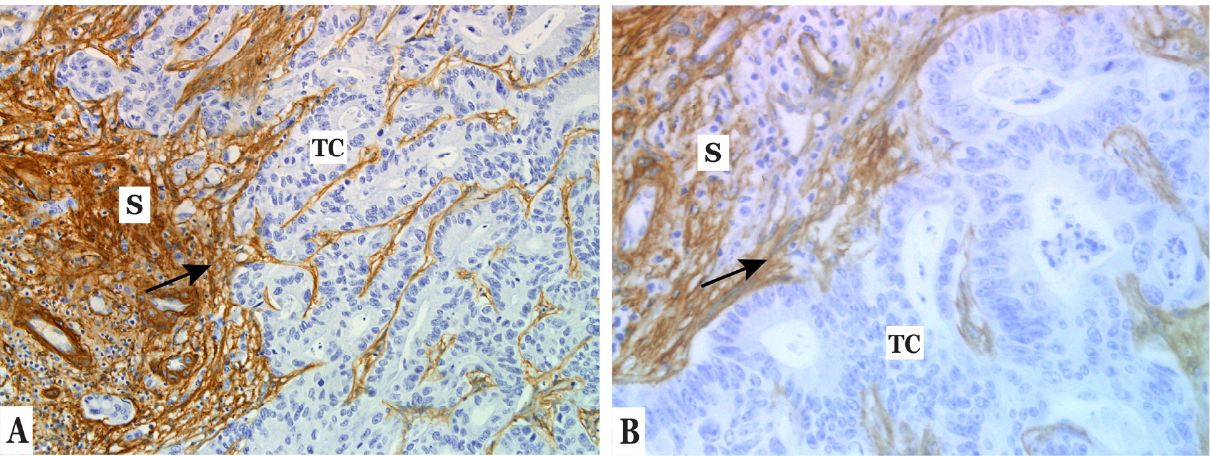
Figure 1. Immunohistochemical staining showing COL IV expression (brown) in stroma (arrow, S) of CLM. ( A ) Magnification ×20 and ( B ) ×40. Abbreviations: TC = tumor cells, S = stroma.